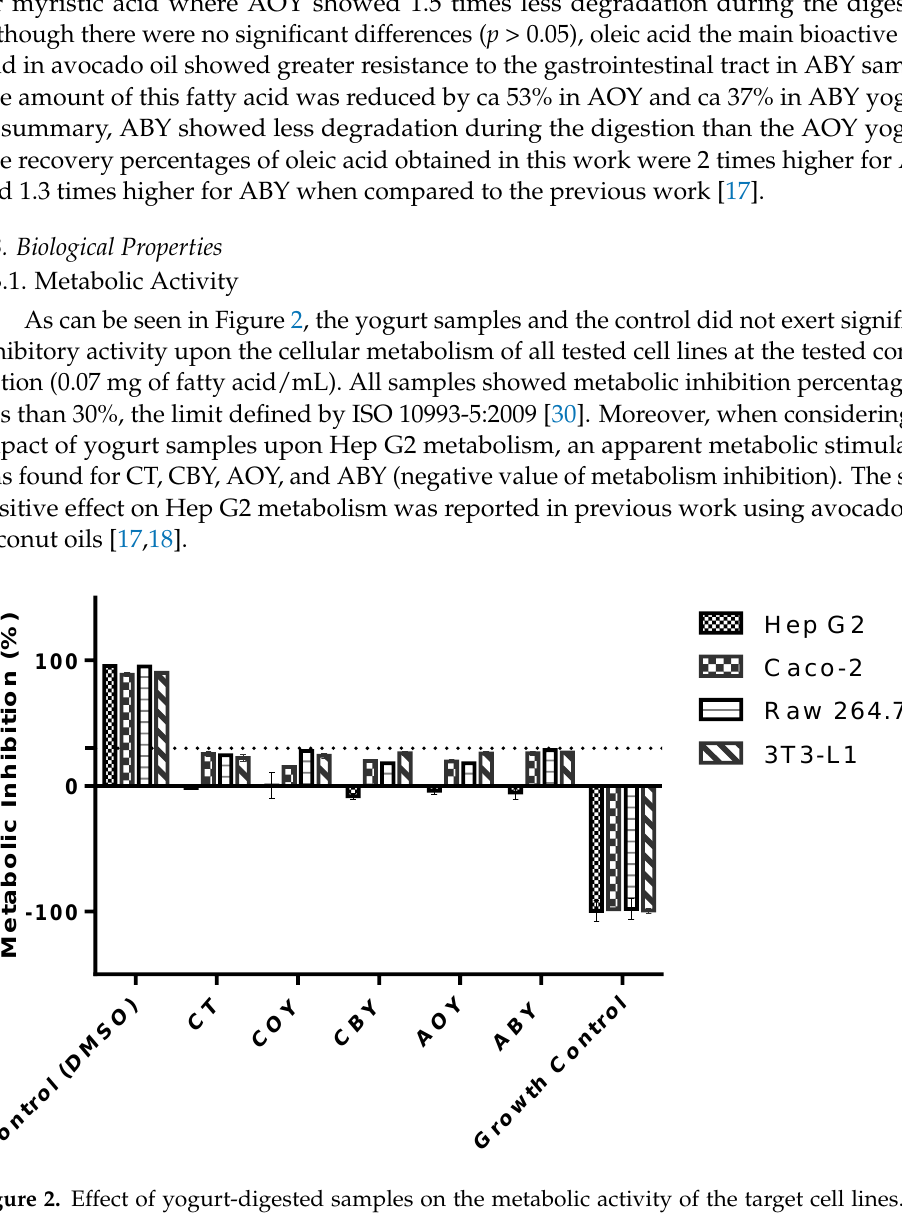
B Figure 3. Hepatic lipid accumulation results for the different yogurts ( A ) without induced steatosis; ( B ) steatosis induced. Different letters mean significant differences between yogurts as determined by a one-way ANOVA test ( p < 0.05). CT — control yogurt, COY — coconut oil yogurt; CBY — coconut bigel yogurt; AOY — avocado oil yogurt; ABY — avocado bigel yogurt. No significant differences ( p ˃ 0.05) were observed between the control and fortified yogurts. These results showed an improvement (20%) in the bioactive fatty acids ’ positive effect on lipid accumulation when compared with the previous works [17,18]. In the stea- tosis-induced Hep G2 cells, the presence of pre-digested yogurt samples reduced lipid accumulation; however, no statistically significant differences ( p ˃ 0.05) were observed between fortified yogurts and their CT counterpart. Despite this, the avocado oil yogurts reduce 1.1 times more hepatic lipid accumulation (in the steatosis-induced model) than